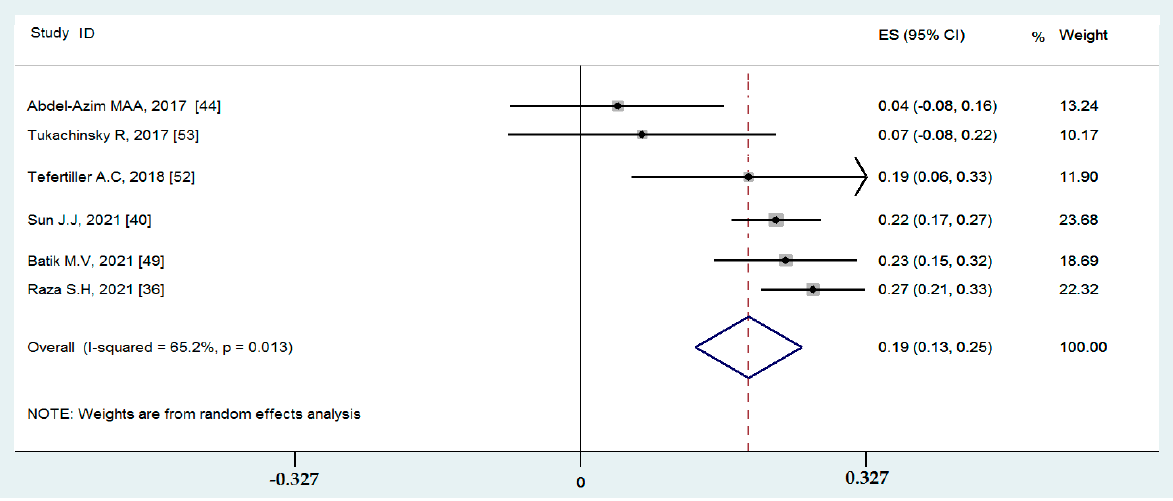
Figure 12. The forest plot displaying the estimated pooled Fisher’s z-score in the association between binge-watching and loneliness.